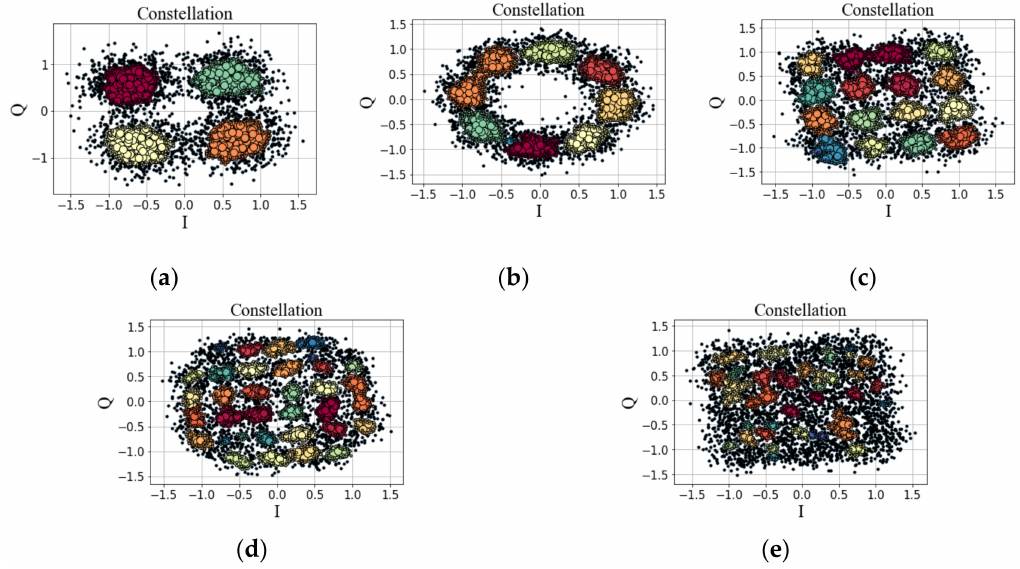
Figure 2. Clustering results for five MFs. ( a ) QPSK; ( b ) 8PSK; ( c ) 16QAM; ( d ) 32QAM; ( e ) 64QAM.